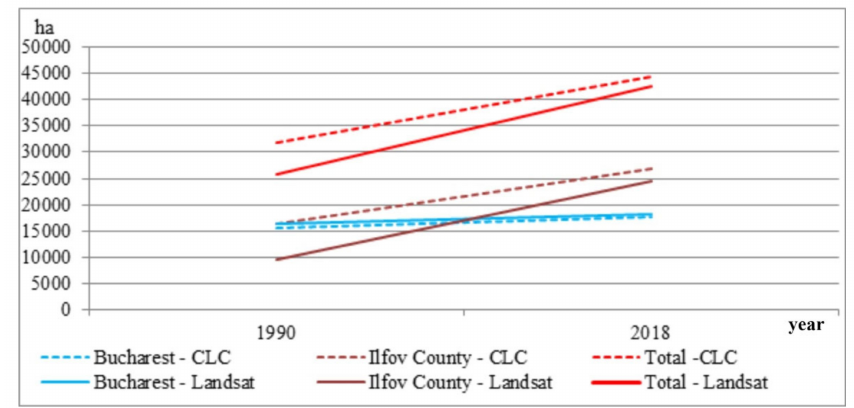
Figure 5. Built-up area dynamics between 1990 and 2018, as resulted from CLC and Landsat classification datasets.